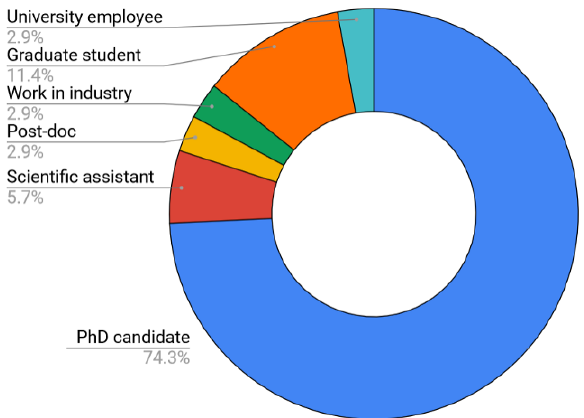
Figure 11. Frequency distribution of trainee positions at time of training